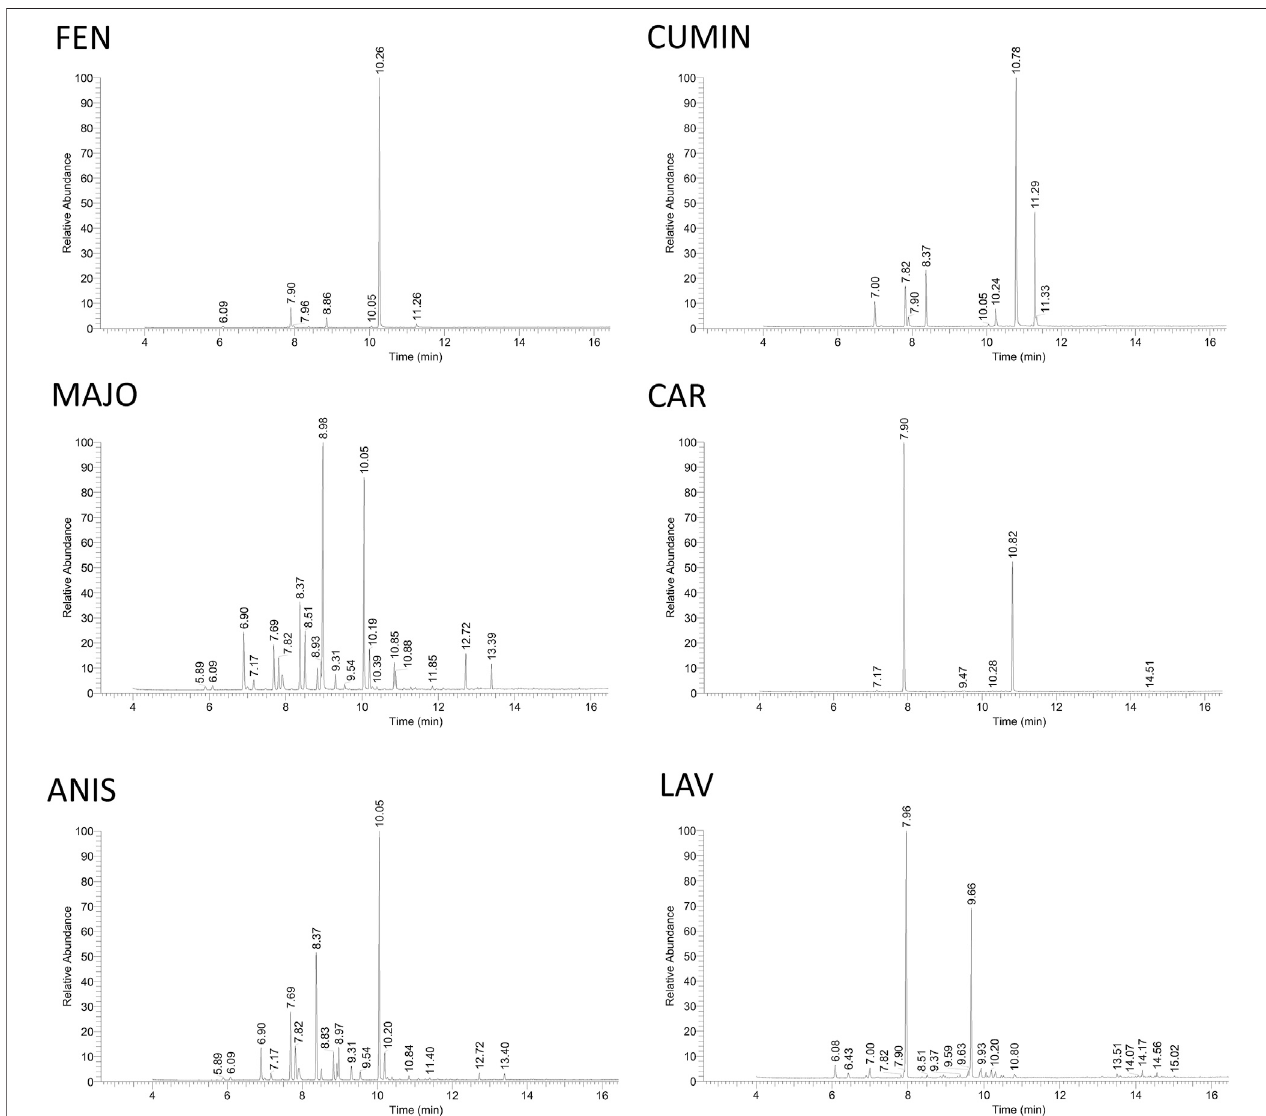
FIGURE8| GC-MS analysisofvolatile oils.The quantitative analysiswasdone byintegrating peaks ofeach detected compound using Thermo Scienti fi cExcalibur software.TheidentityofcompoundswasassessedbycomparisonoftheirmassdatawithNISTlibrarydata,literatureaswellascalculatedKovat ’ sretentionindexbased on standard hydrocarbon mixture (see Table 4 ). FEN, fennel volatile oil; CUMIN, cumin volatile oil; MAJO, marjoram volatile oil; CAR, caraway volatile oil; ANIS, anise volatile oil; LAV, lavender volatile oil.